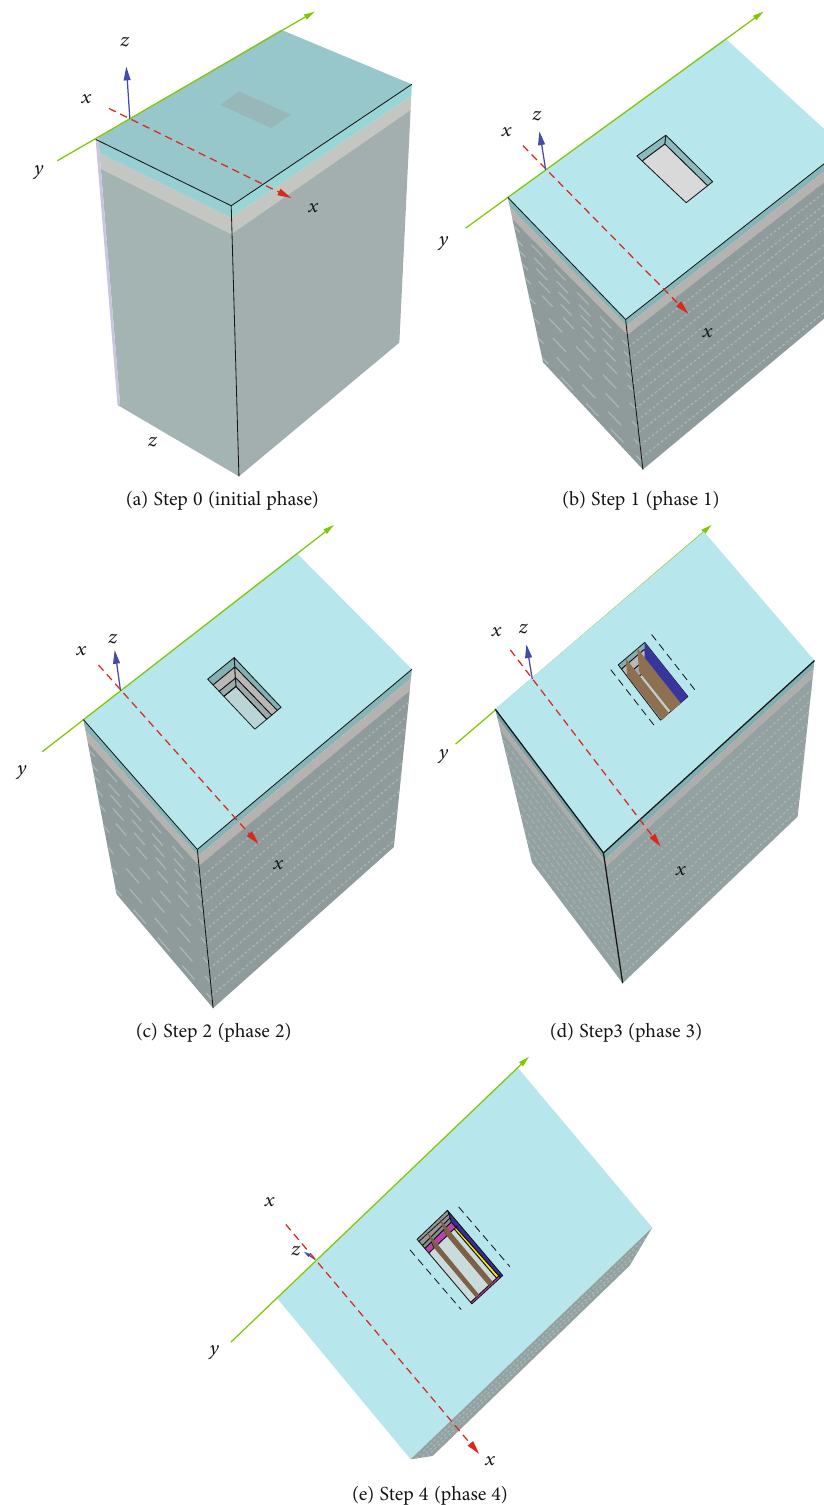
Figure 9: PLAXIS-3D simulation for the construction